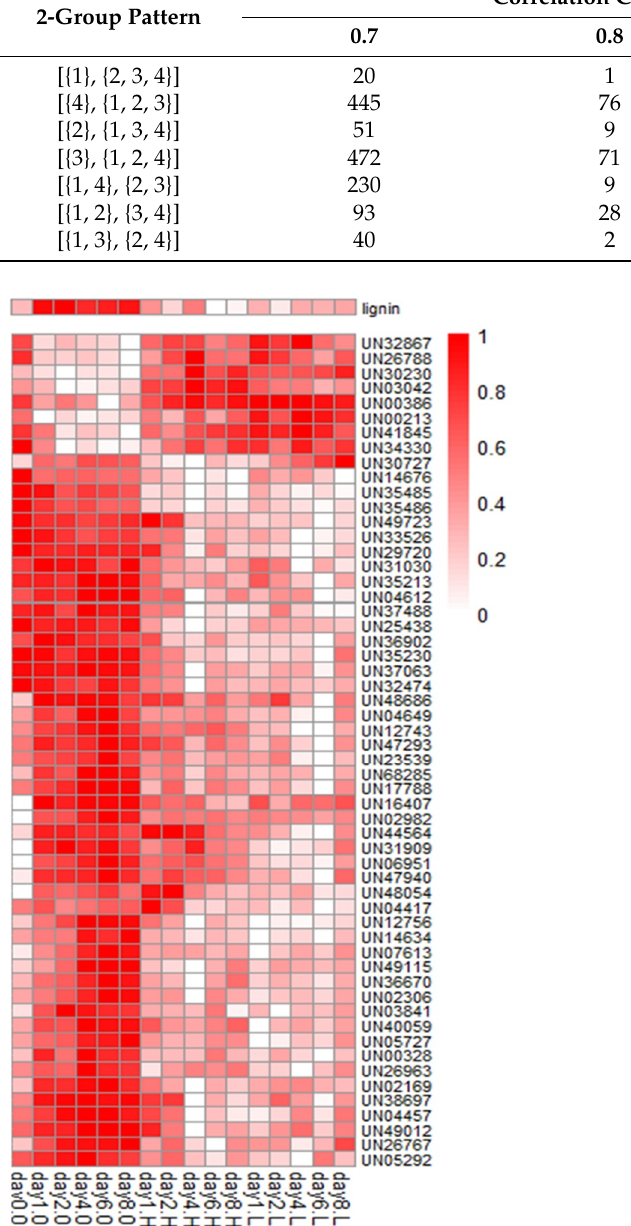
Figure 4. A heatmap of normalized gene expression values of the 53 highly correlated genes in gene expression vs. lignin content comparison, as calculated by the C-CorA method.